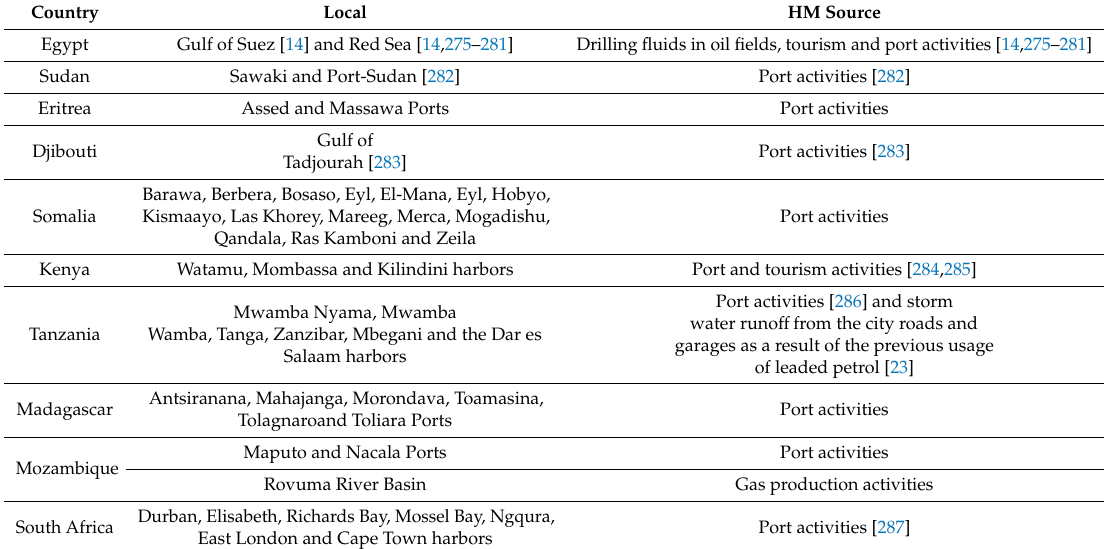
Table 3. Main sources of HM and countries with a monitoring program in the African countries bordering the Indian Ocean and the Red Sea.